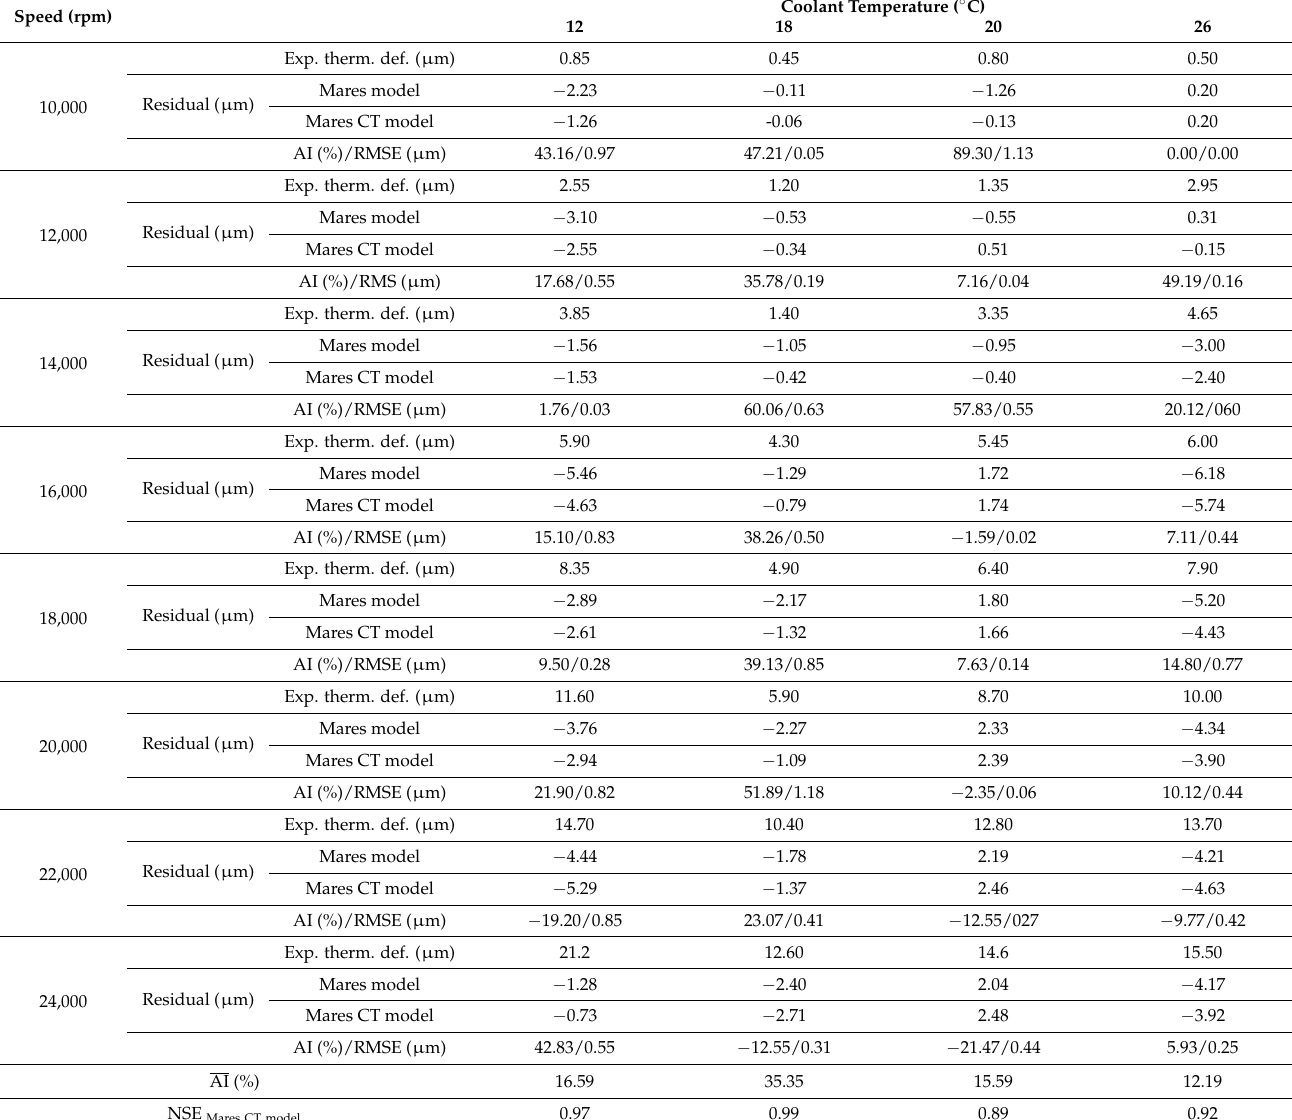
Table 3. Residual thermal errors, AI, RMSE, and AI between the Mares and Mares CT models over the experimental thermal deformation (exp. therm. def.) and NSE of the Mares CT model over the experimental thermal deformation (exp. therm. def.) in the dynamic operation at different coolant temperatures and spindle rotating speeds at a constant flow rate of 5 LPM and 26 ◦ C ambient temperature with a standalone built-in spindle